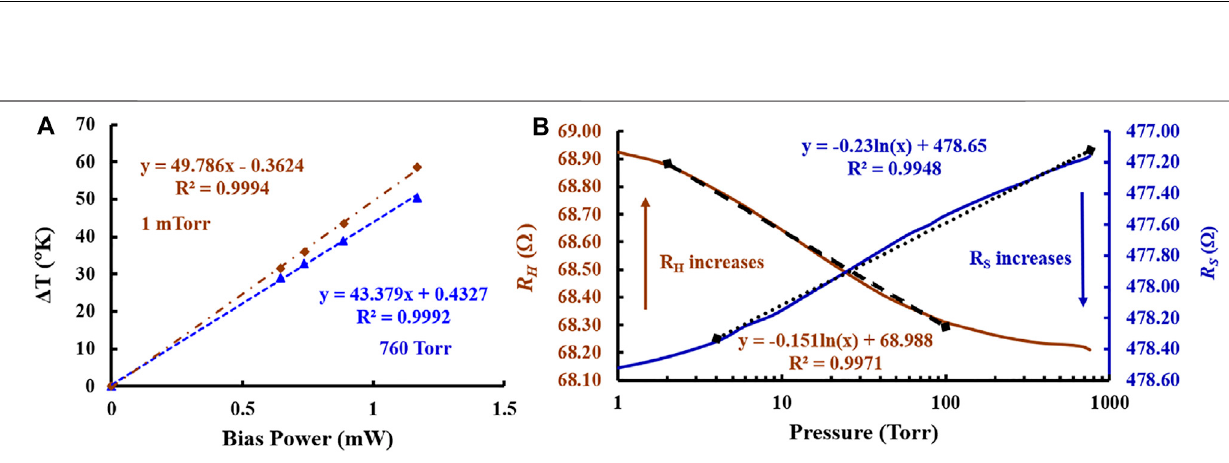
FIGURE 12 | Pirani gauge operation showing (A) temperature-bias power characteristics of Poly-1 for 1 mTorr (brown) and 760 Torr (blue) and (B) resistance vs. pressure graph for the heater ( R H ) [brown] and sensing ( R S ) [blue] resistances.